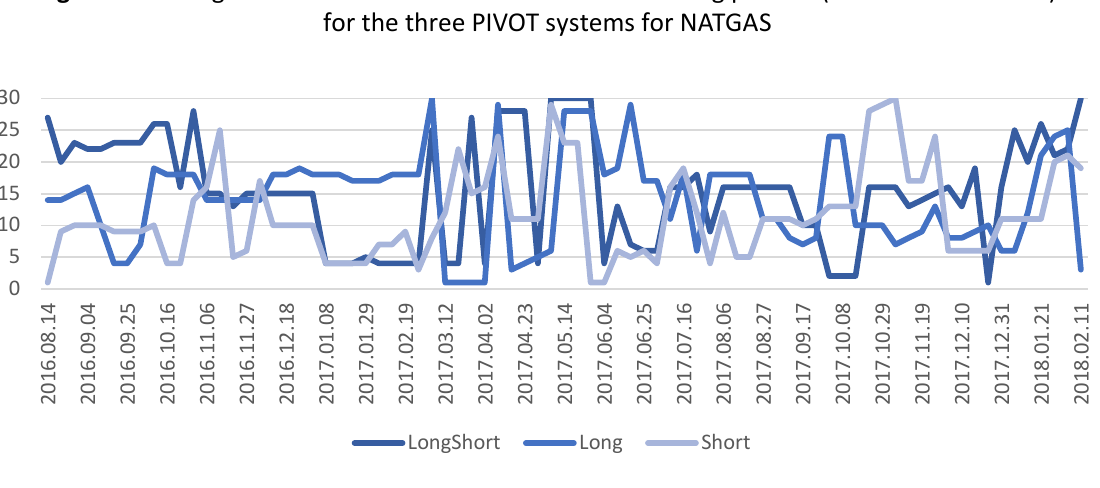
Figure 11. A diagram that shows the values of the backtesting periods (in number of weeks) for the three PIVOT systems for